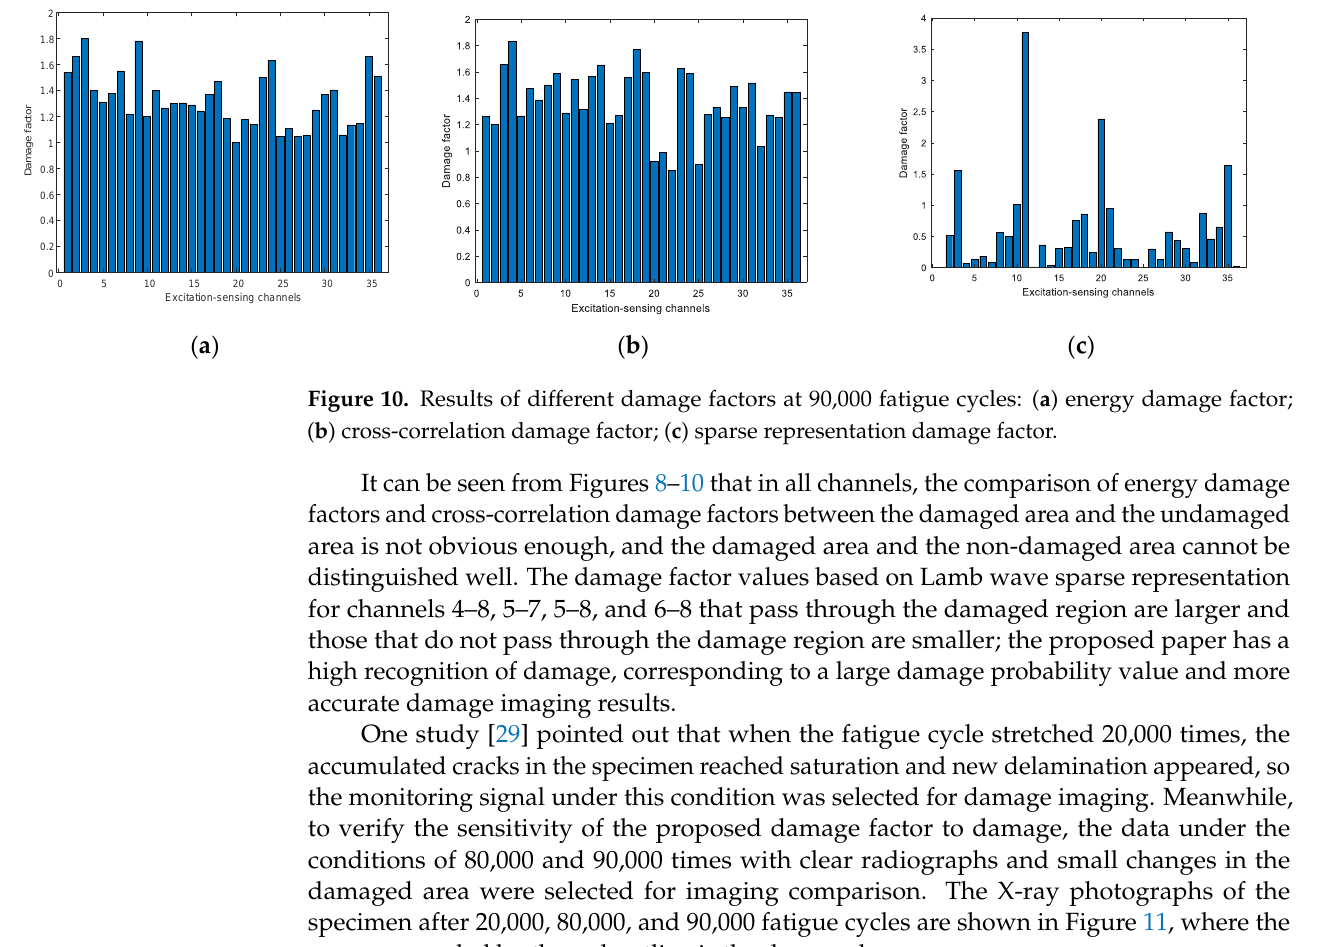
Figure 9. Results of different damage factors at 80,000 fatigue cycles: ( a ) energy damage factor; ( b ) cross-correlation damage factor; ( c ) sparse representation damage factor.